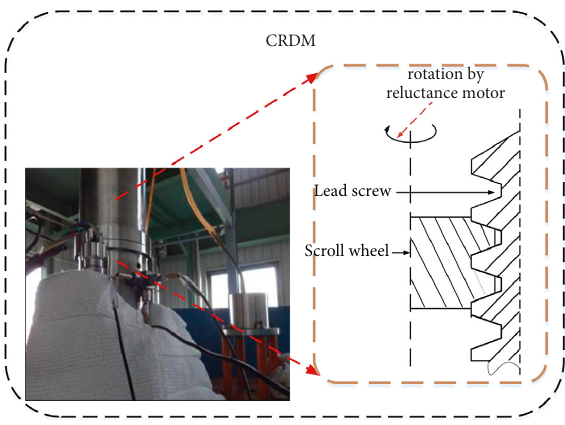
Figure 1: The sketch of the reluctance motor type